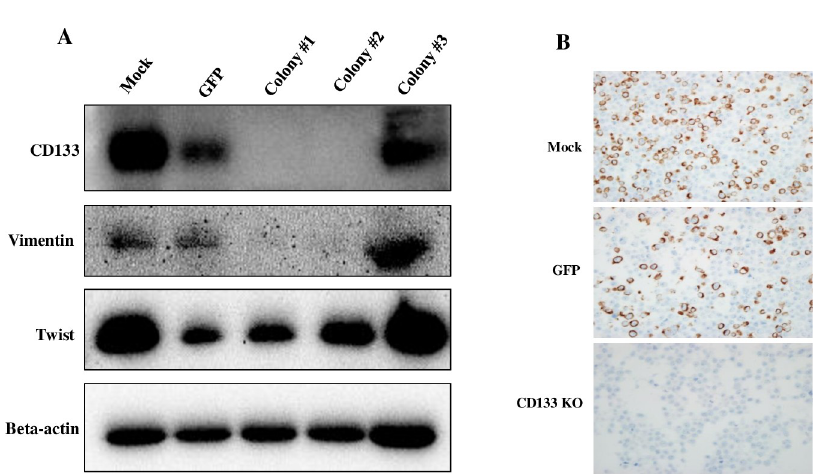
Fig 5. CD133 knockout cells showed loss of vimentin expression. ( A ) Among the EMT-related proteins examined in the current study, it is remarkable that vimentin expression has disappeared in CD133 knockout colon cancer cells in #1 and #2 colony incontrast to positive in CD133 + cells in #3 colony and Mock. ( B ) The immunohistochemical staining on cell blocks also showed loss of vimentin expression in CD133 knockout cells compared with control (mock and GFP).